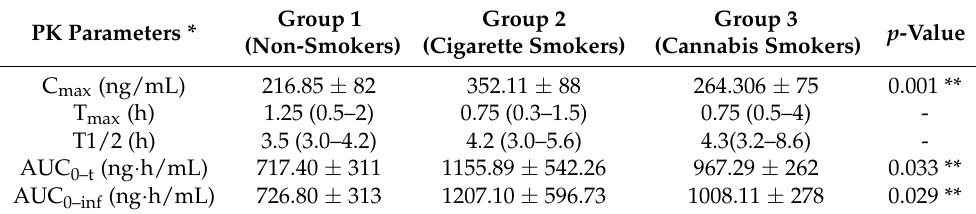
Table 3. Pharmacokinetic (PK) parameters of sildenafil after administering a single oral dose of sildenafil 50 mg tablets in all study